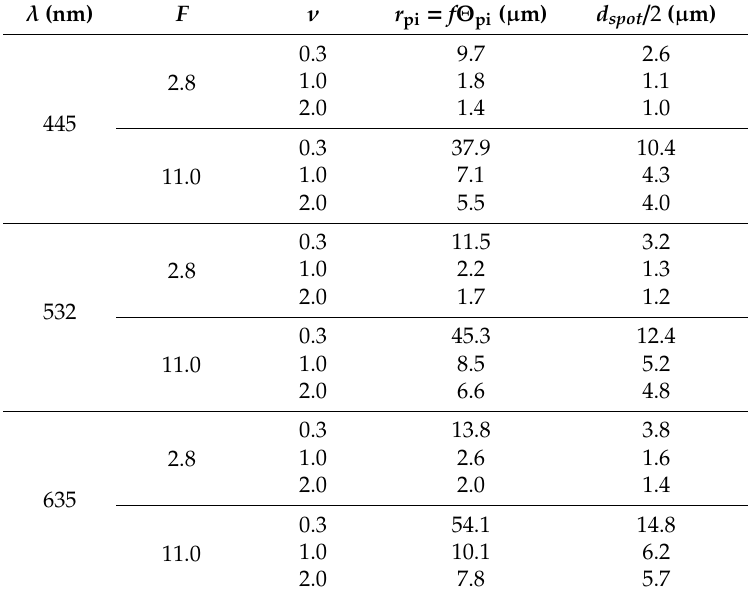
Table 1. Numerically calculated values of the point of intersection r pi of the mean irradiance according Equation (17) and the Gaussian approximation of the central lobe according Equation (18) for di ff erent values of wavelength λ , f -number F and truncation factor ν . Additionally, the spot radius d spot /2 according Equation (19) is listed for comparison. λ (nm) F ν r = f Θ pi pi ( µ